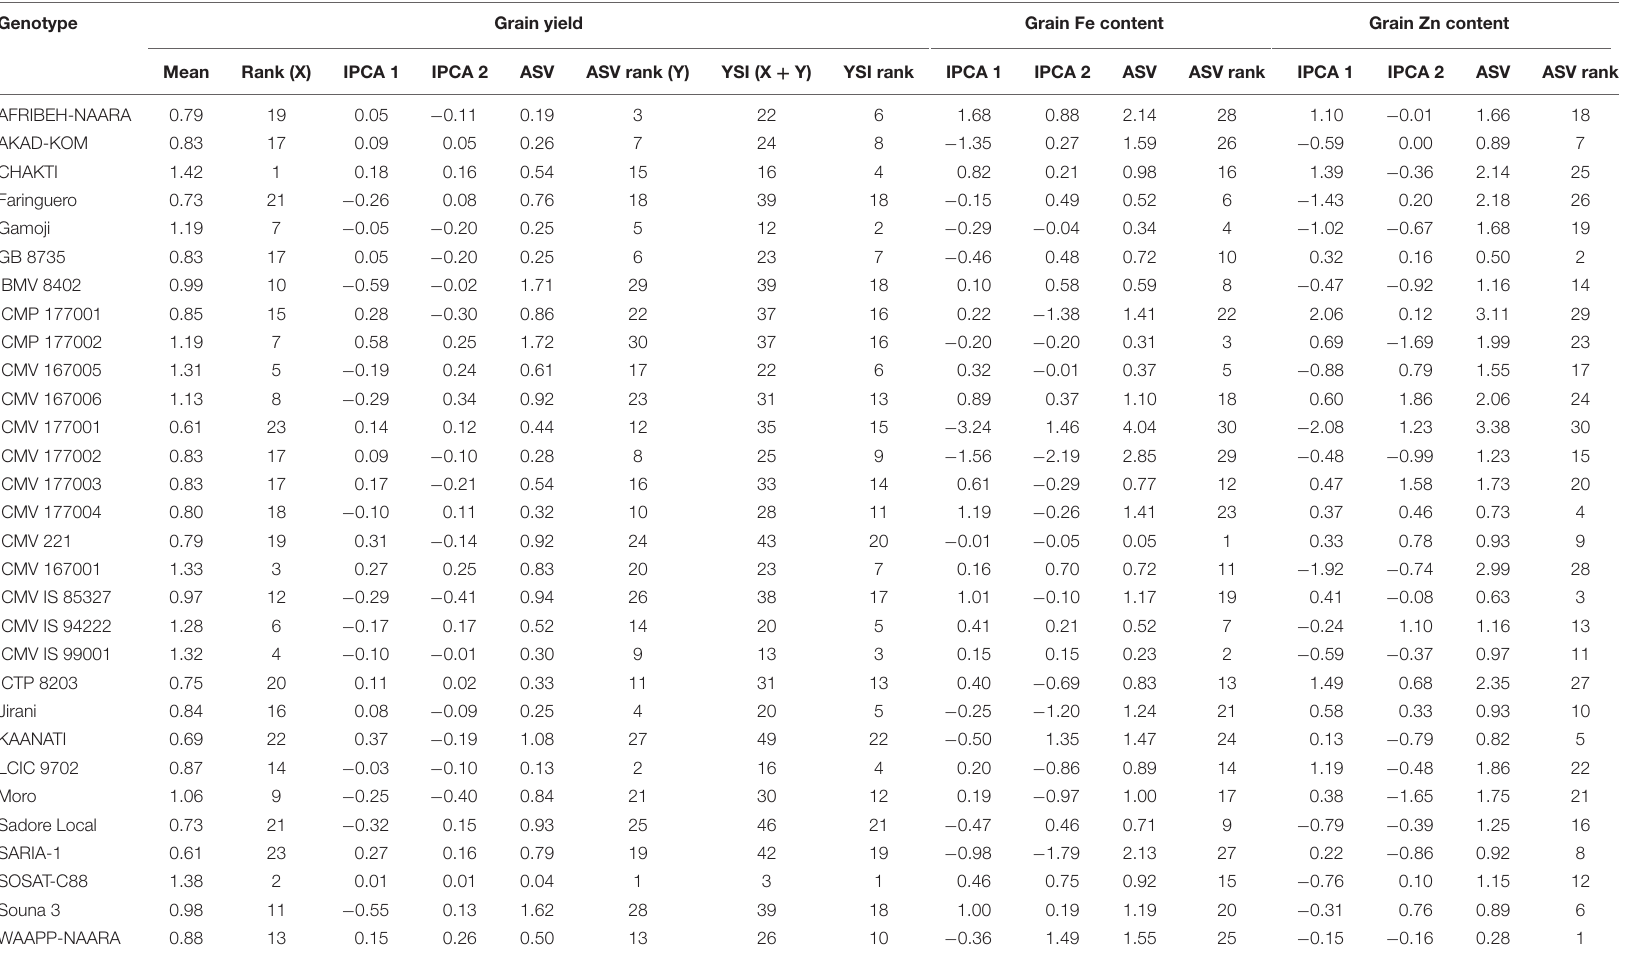
TABLE 4 | Interaction principal component axis scores of agronomic and morphological traits of pearl millet genotypes across locations in West Africa. Genotype Grain yield Grain Fe